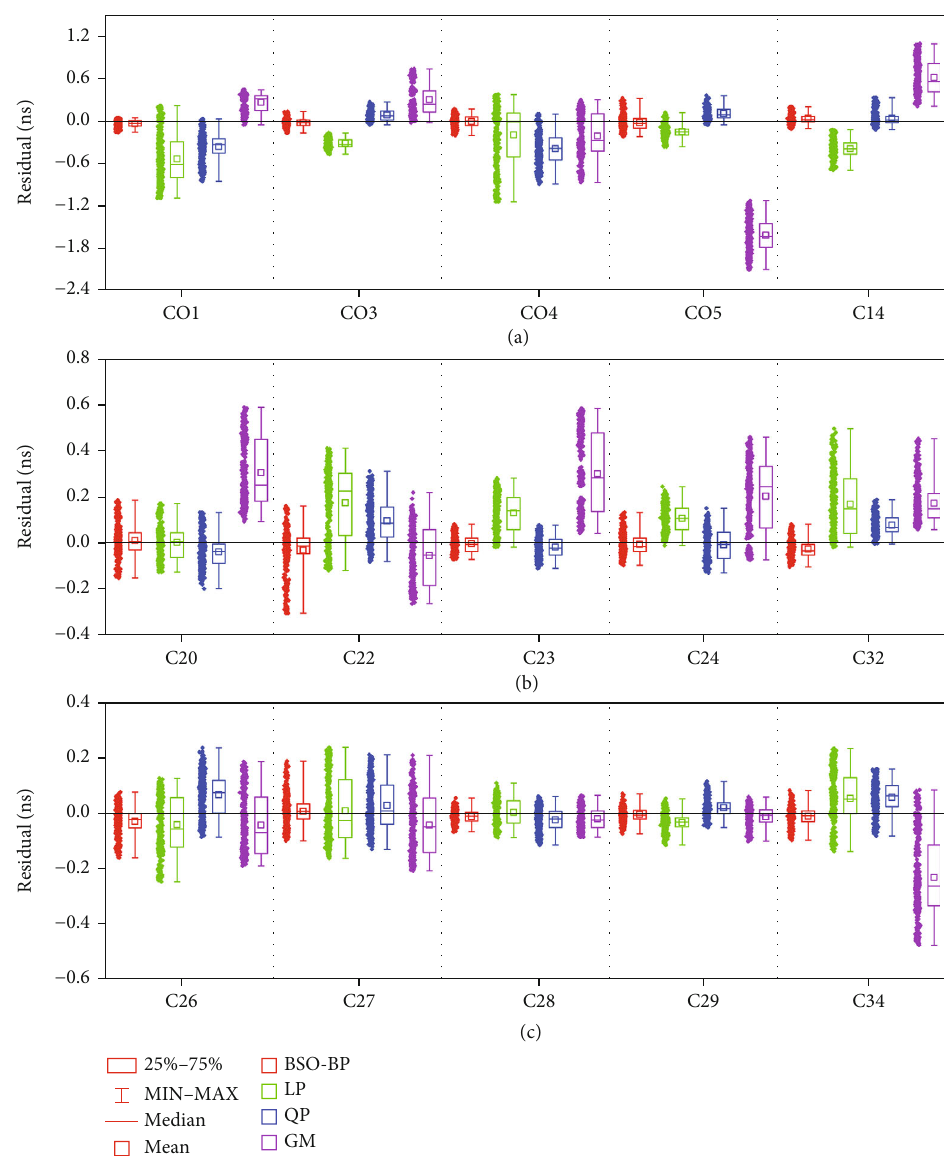
Figure 13: The statistics of 1-hour average STD of four models based on 12-hour SCB data: (a) residual distribution of fi ve Rb clocks; (b) residual distribution of fi ve Rb-II clocks; (c) residual distribution of fi ve PHM